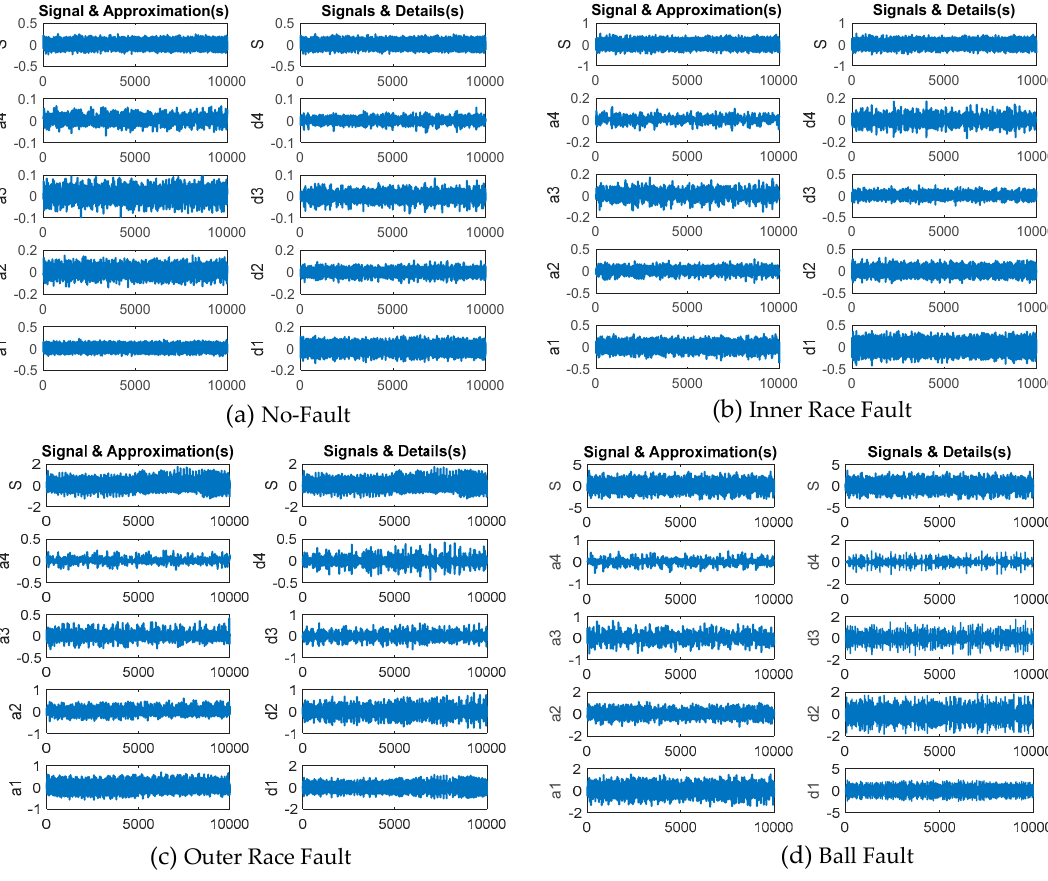
Figure 6. The four ‐ level wavelet decomposition of four classes of bearing conditions. Figure 6. The four-level wavelet decomposition of four classes of bearing